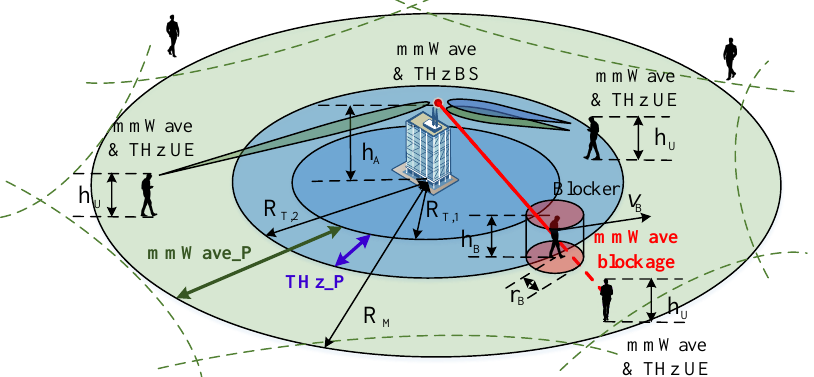
Figure 1. The considered 6G deployment with collocated mmWave/THz